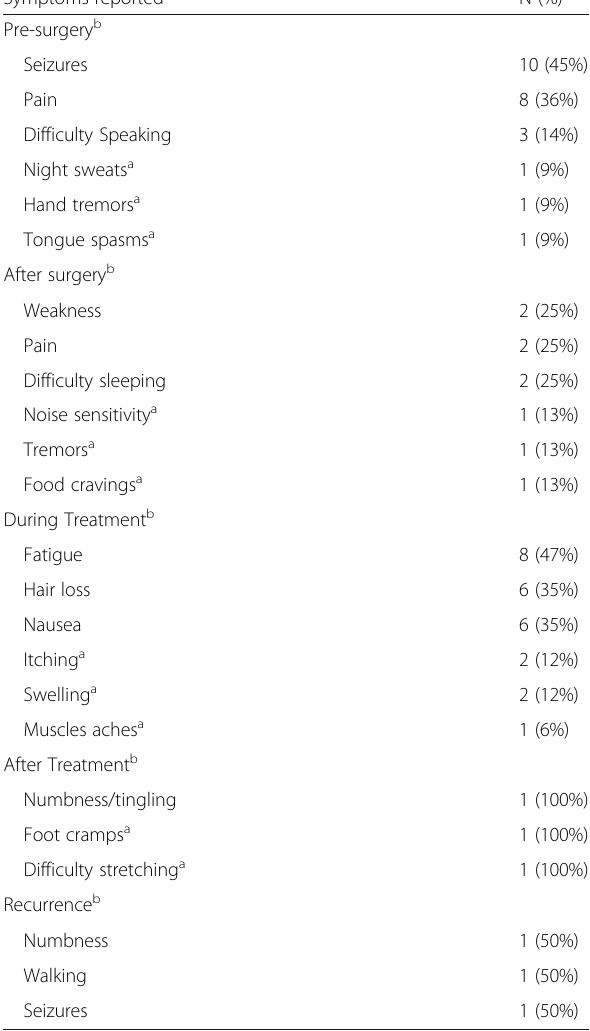
Table 4 Endorsed Symptoms During Interviews at Different Stages of Patient Diagnosis Symptoms